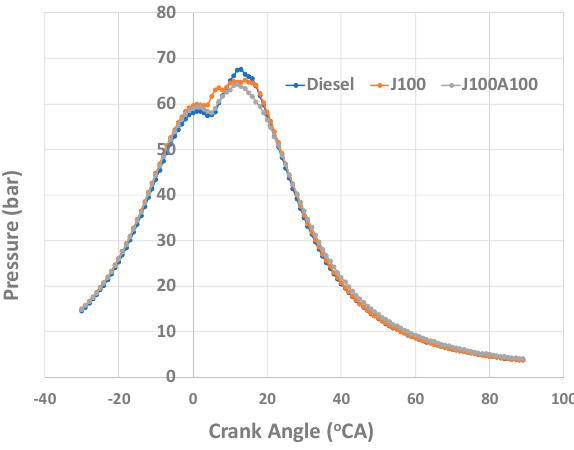
Figure 11. Cylinder pressure at 60% load.